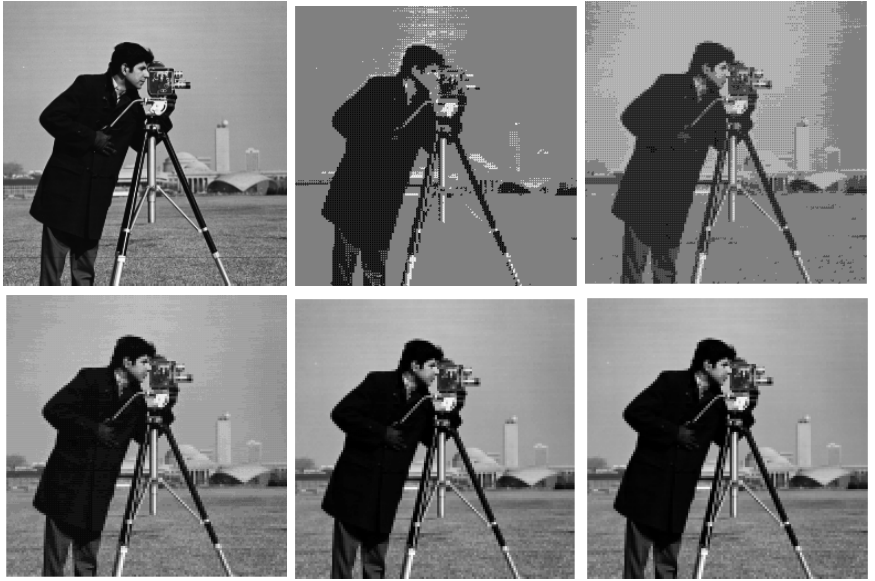
Figure 5: Top left corner: orinal image; left to right: reconstructed Cameraman image using 2 × 2 blocks at quality indices 5 , 10 , 50 , 90 , 95